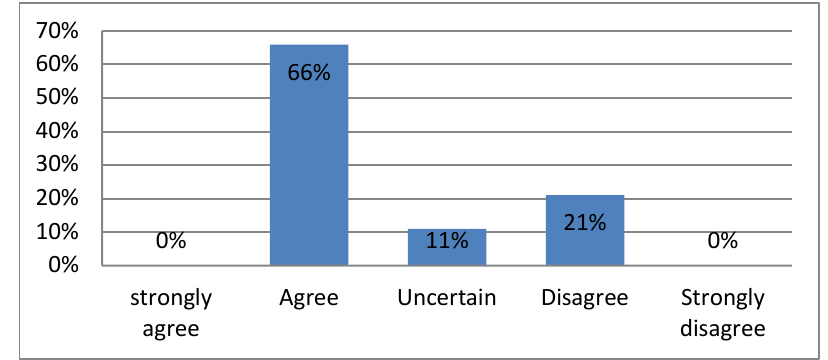
Figure 2 : advertisement make a brand stronger.